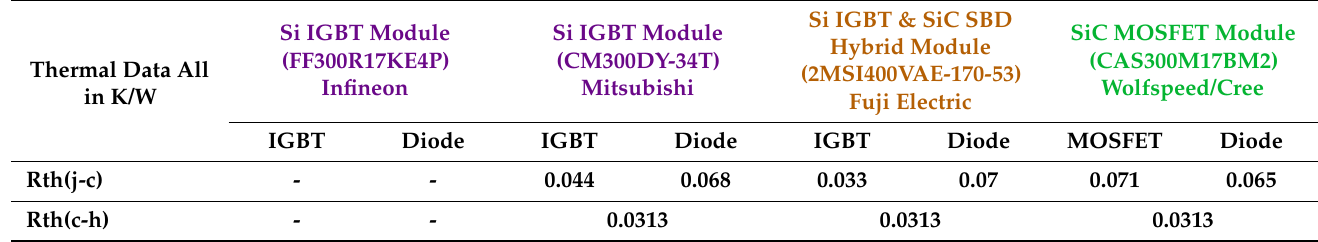
Table A1. Thermal resistances of SiC MOSFET module in comparison with hybrid and Si-IGBT modules and different heatsink sizes.